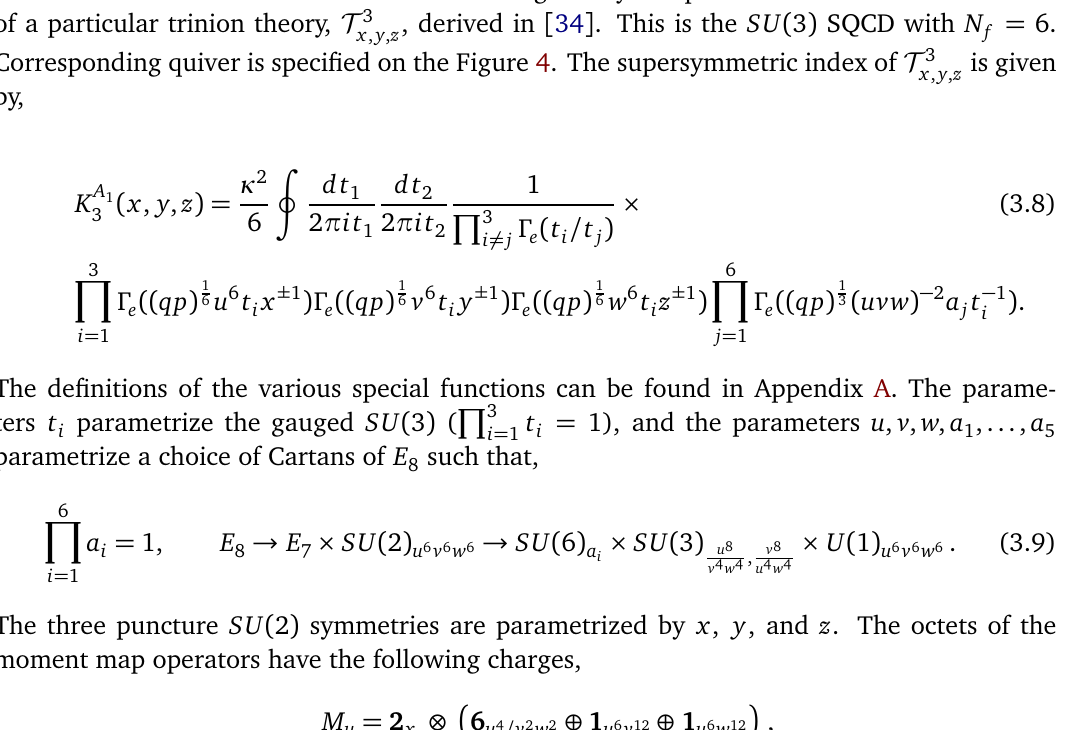
global symmetry 8 = f